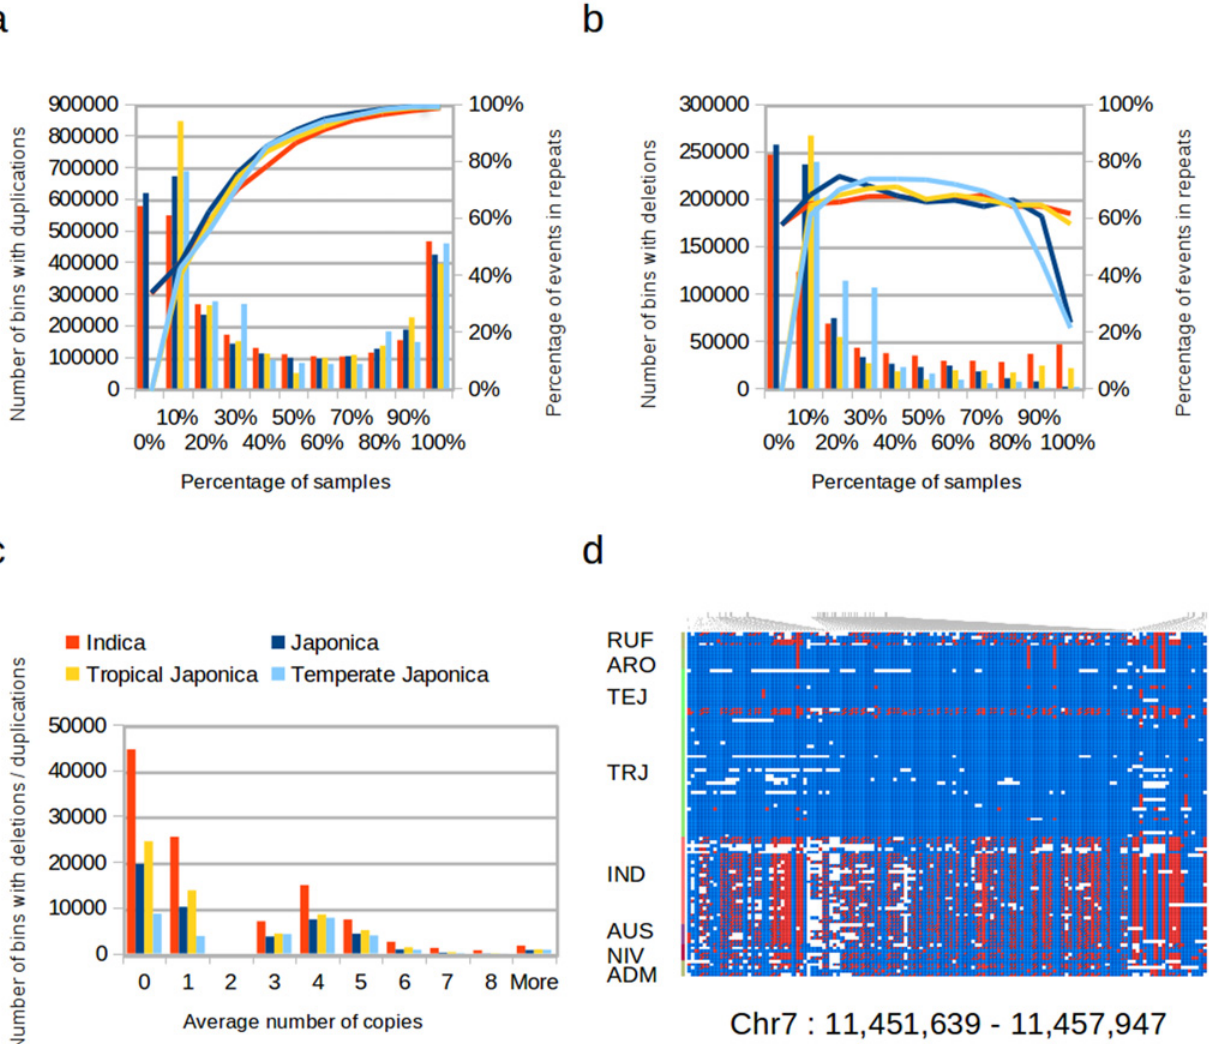
Fig 2. Comparison of CNV calls in rice cultivars. Number of 100bp bins with a) duplications, and b) deletions discriminated by the percentage of each population in which the event is reported (red: Indica, blue: japonica overall, yellow: tropical japonica, and light blue: temperate japonica). The lines indicate the percentage of bins for each category falling within repetitive regions in Nipponbare. c) Number of bins not spanning Nipponbare repeats with predicted CNVs common for each subpopulation (indica, japonica, tropical japonica, and temperate japonica) discriminated by the predicted copy number, being two the normal copy number for a diploid region. d) Example of a discriminative duplication between indica and japonica. Reads taken from the two copies of this region present in indica samples align to the same genomic location producing clusters of heterozygous SNPs. Colors in the left panel differentiate the following groups: O. rufipogon (RUF), aromatic (ARO), temperate japonica (TEJ), tropical japonica (TRJ), indica (IND), aus (AUS), O. nivara (NIV), and admixed (ADM). Homozygous genotype calls carrying the reference allele are colored blue. Homozygous genotype calls carrying an allele different from the reference are colored red. Heterozygous genotype calls are colored half blue and half